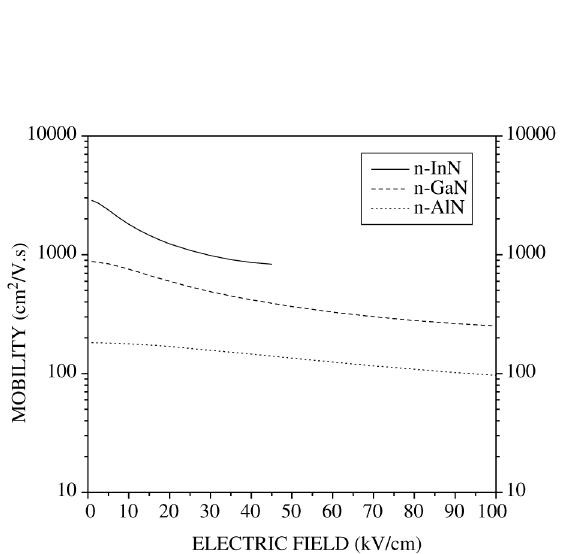
Figure 3. Electric field dependence of the different contributions to the electron mobility in wurtzite n-GaN. The lattice tempera- ture is T = 300 K and n = 10 17 cm -3 . 0